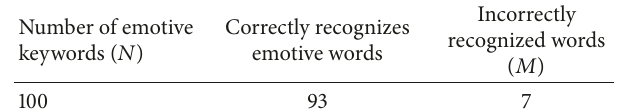
Table 5: Accuracy of recognizing emotive